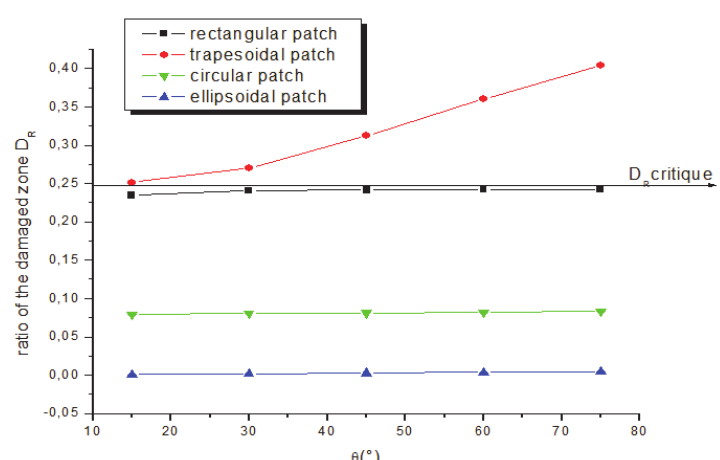
Figure 12: Ratio of the damaged zone according to the crack tilt for the different patch shapes.